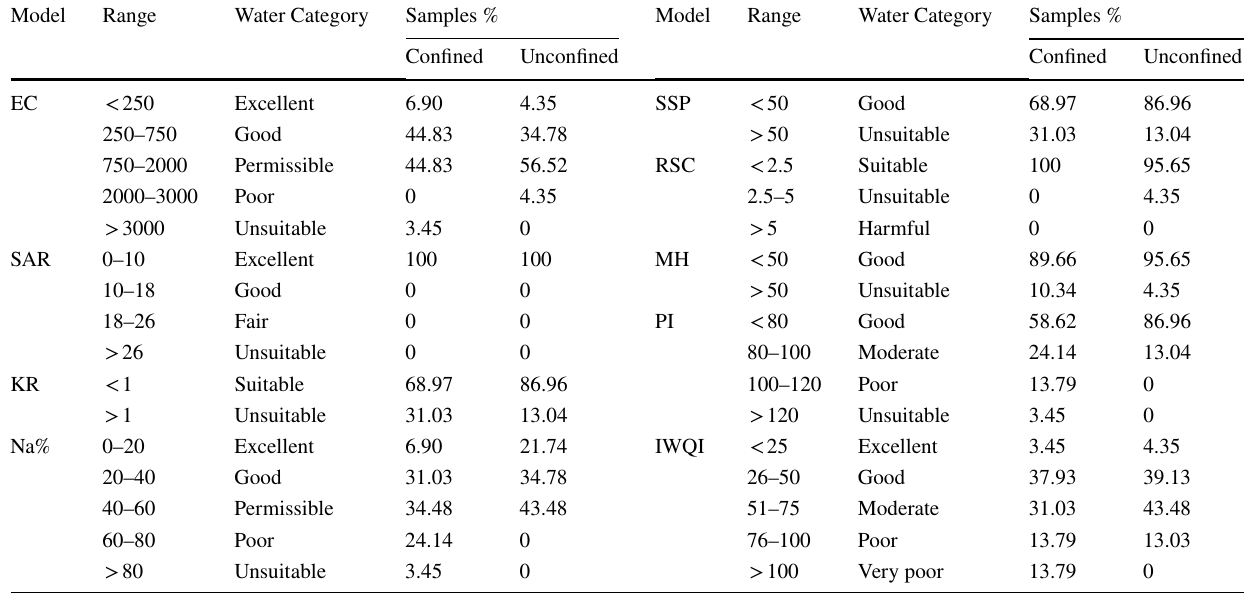
All parameters unit in Meq/l, except the EC (µmhos/cm), Cl and NO 3 in (mg/l) and pH Table 10 Rating of the groundwater samples utilized for irrigation based on the EC, SAR, KR, Na%, SSP, RSC, MH, PI indices, and a new approach Model